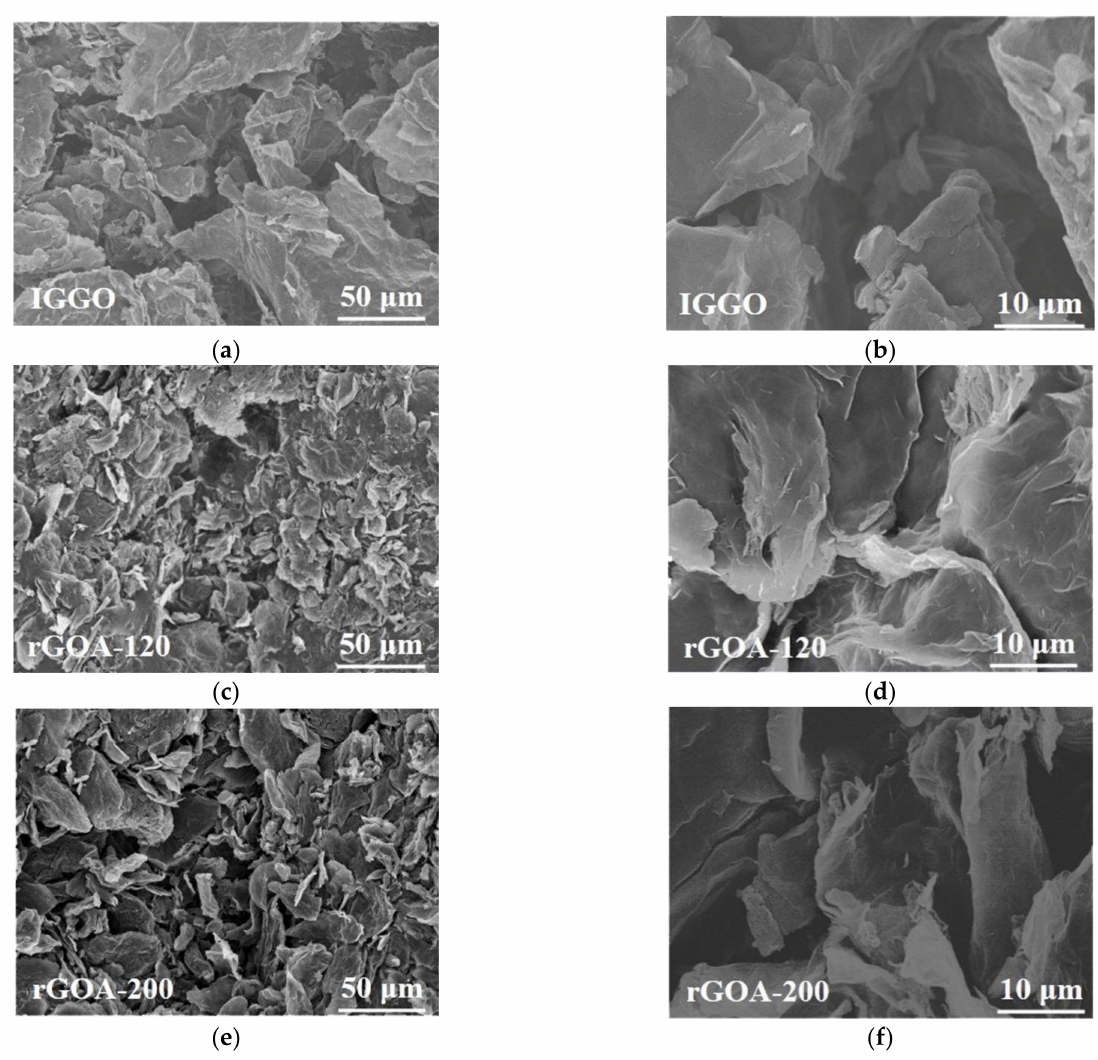
Figure 5. SEM images of IGGO ( a , b ), rGOA-120( c , d ) and rGOA-200 ( e , f ).